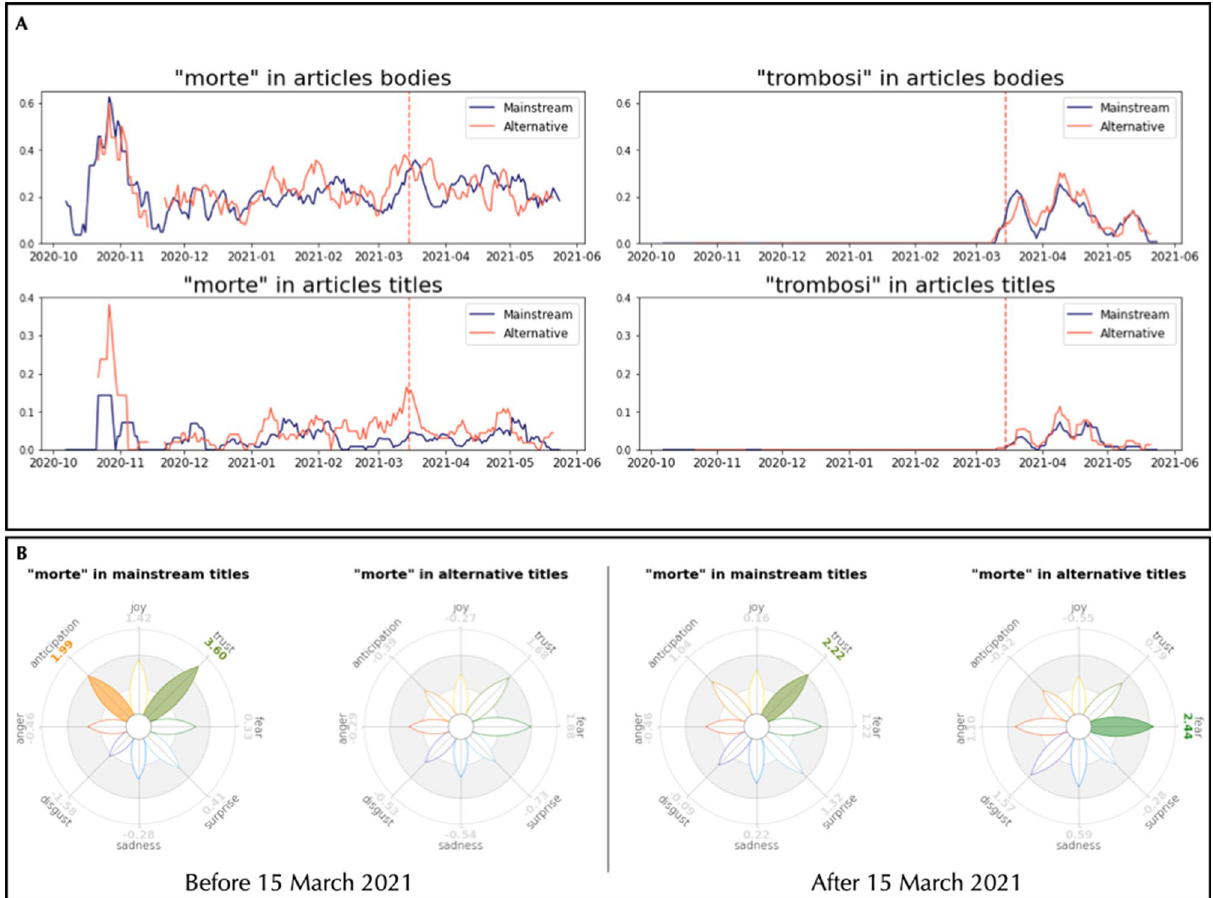
Figure 4. ( A ) Fraction of news that mention “mort” (death) and “trombos” (thrombosis) in their bodies and titles over the total of mainstream news (blue) and alternative news (red), smoothed by a moving average of the last 7 days. ( B ) Distribution of emotions in the semantic frame of “mort” (death) in the titles of mainstream and alternative titles (cf. 3 bottom left). Always within titles coming from alternative news media, the semantic community of “astrazenec” underwent a densification of negative associations . This included links with thrombosis , threat and dangerous that were not present before. Mainstream journals produced semantic communities framing “astrazenec” in similar ways before and after the temporary suspension of the vaccine. Noticeably, mainstream venues featured associations with clusters of concepts related to bureaucracy, underlining how the vaccine was under further scrutinise. A further analysis driven by the events of March 15 can be conducted by tracking the usage of words associ- ated to the negative events: death and thrombosis , the main alleged side effect that was put under the spotlight. An analysis of the prevalence of these two words, as shown in Fig. 4A, suggests us that both mainstream and alternative media covered these events in a similar way. The words “mort” (death) and “trombos” (thrombosis) have a long history due to its association with the COVID-19 outbreak, especially during the peak of casual- ties in Fall 2020, in both mainstream and alternative news outlets. The two plots show how many of the news produced by mainstream and alternative outlets everyday included the words “mort” (death) and “trombos” (thrombosis) respectively. Daily values were averaged with a moving average of 7 days, reducing the noise and increasing the readability of the figures. Indeed, they both show a peak of the said words around or after March 15, mentioning death in almost 35% of their articles and thrombosis in the 25% (mainstream) and 30% (alterna- tive) of their articles. Interestingly, “thrombosis” started appearing in article bodies and titles on the eve of March 15, with analo- gous trends in both mainstream and alternative sources. Whereas “mort/death” in article bodies displays a relative increase of + 95% around March 15—compared to the start and end of March—in both alternative and mainstream outlets, article titles highlight a different pattern: Around March 15, titles of alternative out- lets feature “death” 4 times more frequently than titles from mainstream sources. Furthermore, in titles from alternative outlets the occurrence of “death” evidently peaks on March 15, a phenomenon absent in titles from mainstream sources. These differences indicate how different sources provided different attention levels to the concept of death and COVID-19 vaccines. Further emotional analysis based on TFMNs reveals how mainstream and alternative titles framed the concept of “death” in emotionally different ways, cf. Fig. 4B. Before March 15,